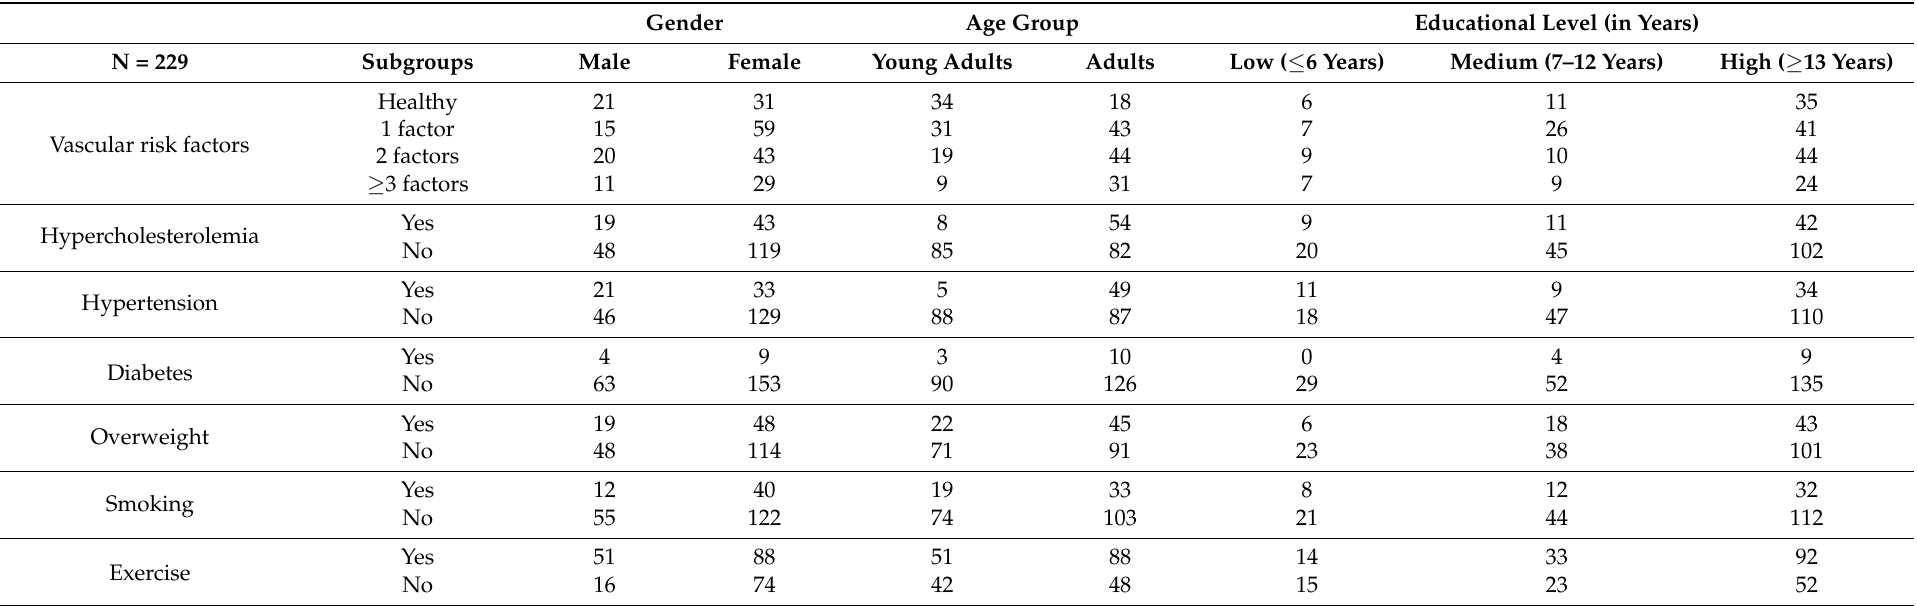
Table 1. Individual–demographic–clinical information for the sample of the